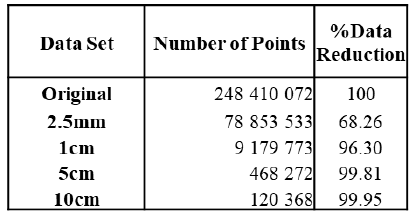
Table 1. Point Cloud dimension and percentage of decimation at each resolution.